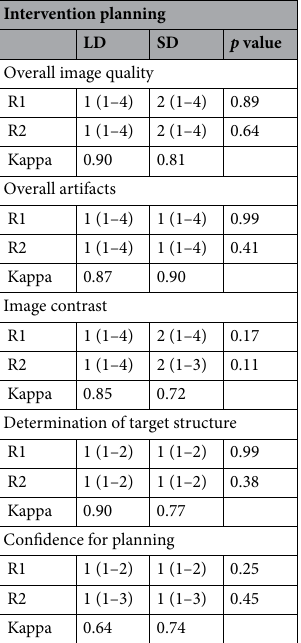
Table 4. Semi-quantitative scoring for intervention planning scans according to evaluations of two readers (R1 and R2) considering scanning with standard dose (SD) and low dose (LD).